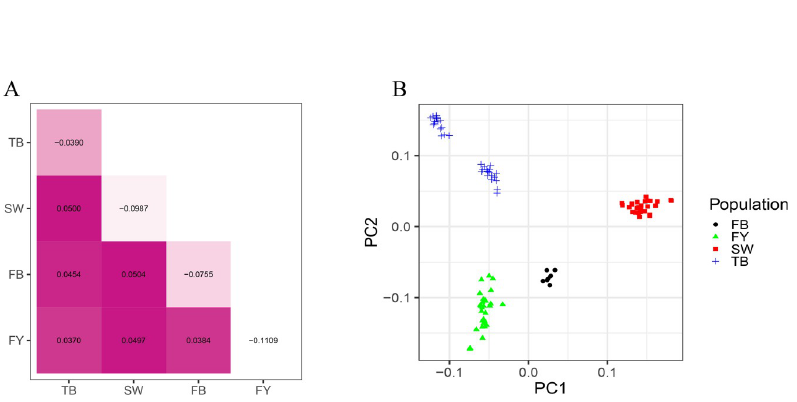
Fig 3. Population structure of the four rabbit breeds. (A) The plot shows the pairwise Wright’s F ST values in the lower triangular area and F IS values in diagonal cells. (B) Plot of pairwise principal components (PC1 and PC2) of four rabbit breeds based on the SNP